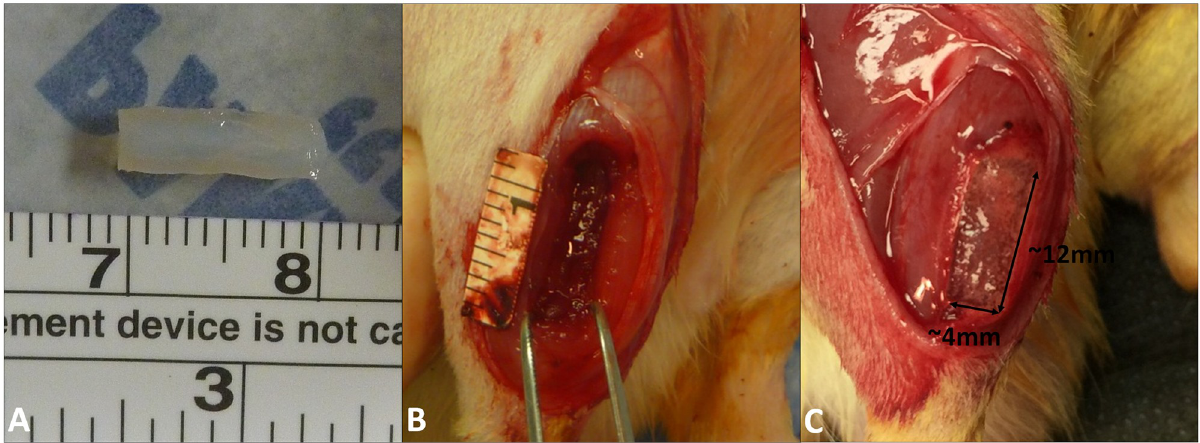
Fig 1. The fabrication of gel constructs and VML injury and treatment in the rat TA muscle. ( A ) Cross-linkedgel constructs before in vitro testing or in vivo implantation. ( B ) A 12x4x4mm near full-thickness VML defect was created in the middle-third of the rat TA muscle. ( C ) A size-matchedgel construct (low OA, high OA or gel only) was placedin the defect for treatment.